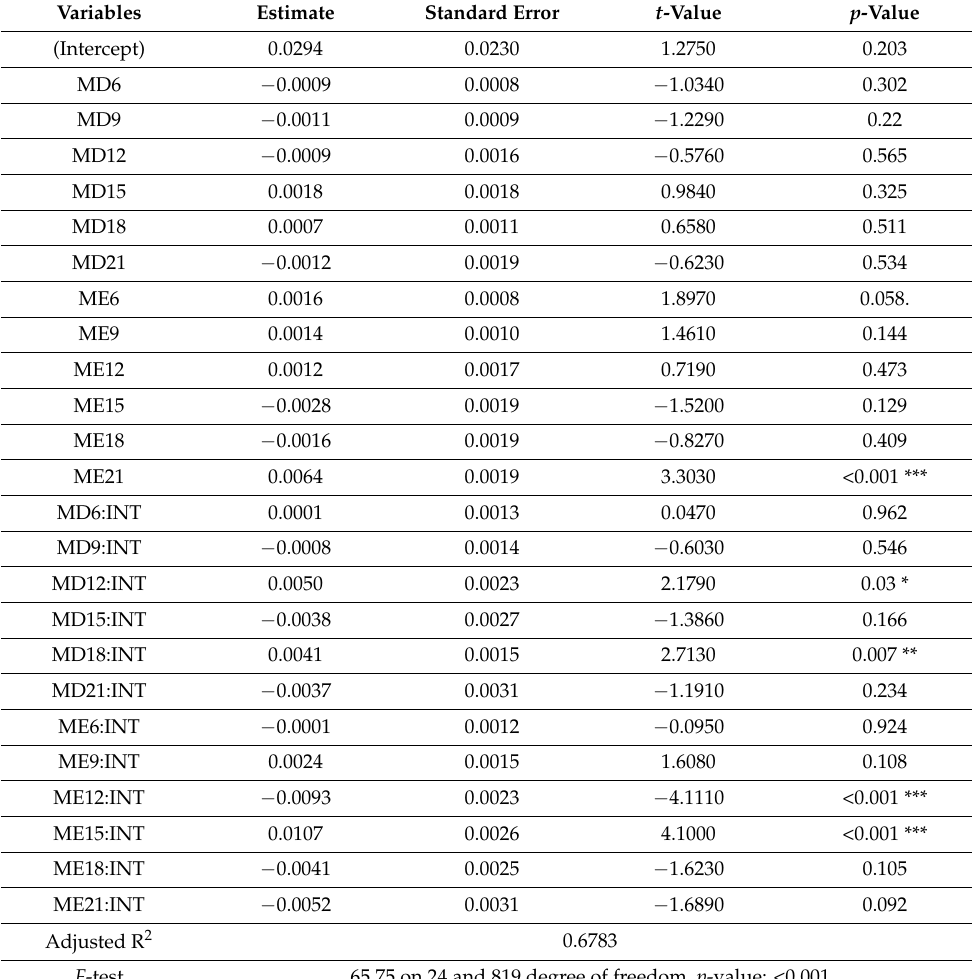
Table 3. Summary of the linear regression result with the statistical interaction